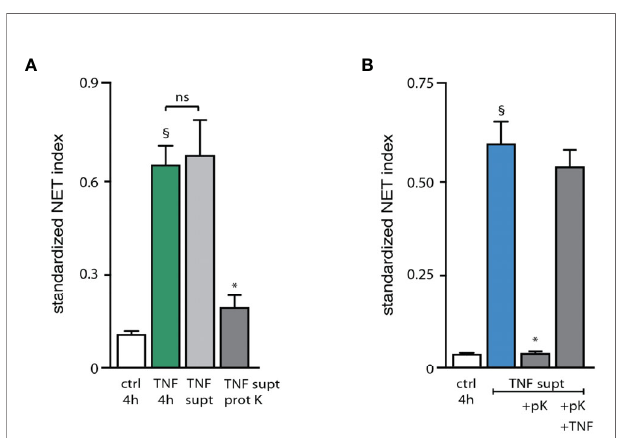
FIGURE 5 | Characterization of the endogenous NET-inducing factors released by activated neutrophils. (A) Neutrophils cultured on poly-L-lysine- coated coverslips were incubated for 4 h with medium alone ( “ ctrl ” ) or with 100 U/ml TNF a . Alternatively, cells were incubated for 3 h in the presence of TNF a . Supernatants were collected, immunodepleted of TNF a as described in Methods , and incubated for 3 h at 37°C in the absence or presence of proteinase K, prior to being added to freshly cultured neutrophils for 4 h ( “ TNF supt ” and “ TNF supt prot K ” , respectively). NET formation was assessed using PlaNET Green as described in Methods . Mean ± s.e.m. from 3 independent experiments. § p < 0.02 vs unstimulated cells; *p < 0.04 vs TNF supernatants without proteinase K. (B) Cells were cultured as described above and incubated for 4 h with medium alone ( “ ctrl ” ). Alternatively, cells were stimulated for 3 h with 100 U/ml TNF a . Supernatants were collected, immunodepleted of TNF a , and incubated for 3 h at 37°C in the absence or presence of proteinase K, prior to being added to freshly cultured neutrophils for 4 h ( “ TNF supt ” and “ TNF supt +pK ” , respectively). In the latter instance, cells cultured for 4 h with proteinase K-digested supernatants were also exposed to 100 U/ml exogenous TNF a ( “ TNF supt +pK +TNF ” ). NET formation was assessed using PlaNET Blue as described in Methods . Mean ± s.e.m. from 3 independent experiments. §p = 0.01 vs unstimulated cells; *p = 0.01 vs TNF supernatants alone (2nd bar). ns, not signi fi